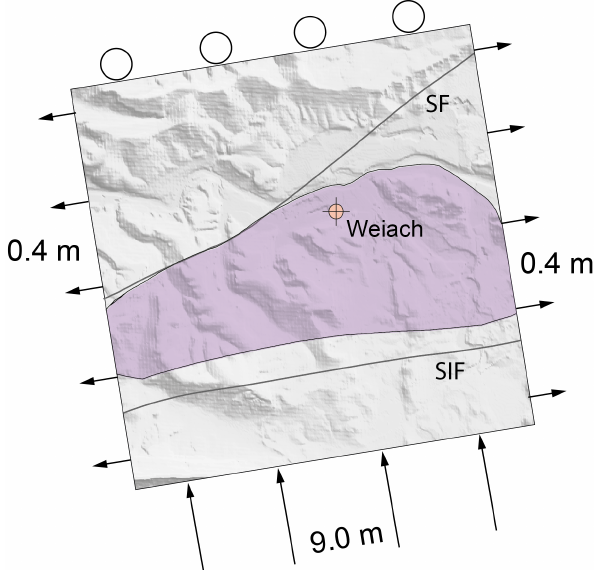
Figure 8. Displacement boundary conditions of model BM. Circles at the northern model boundary denote that no displacement per- pendicular to the boundary is allowed, but parallel to it. Thin lines indicate the two implemented faults SF and SIF; purple area shows the extent of the siting area Nördlich